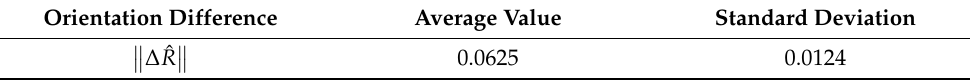
Table 2. The difference between hand